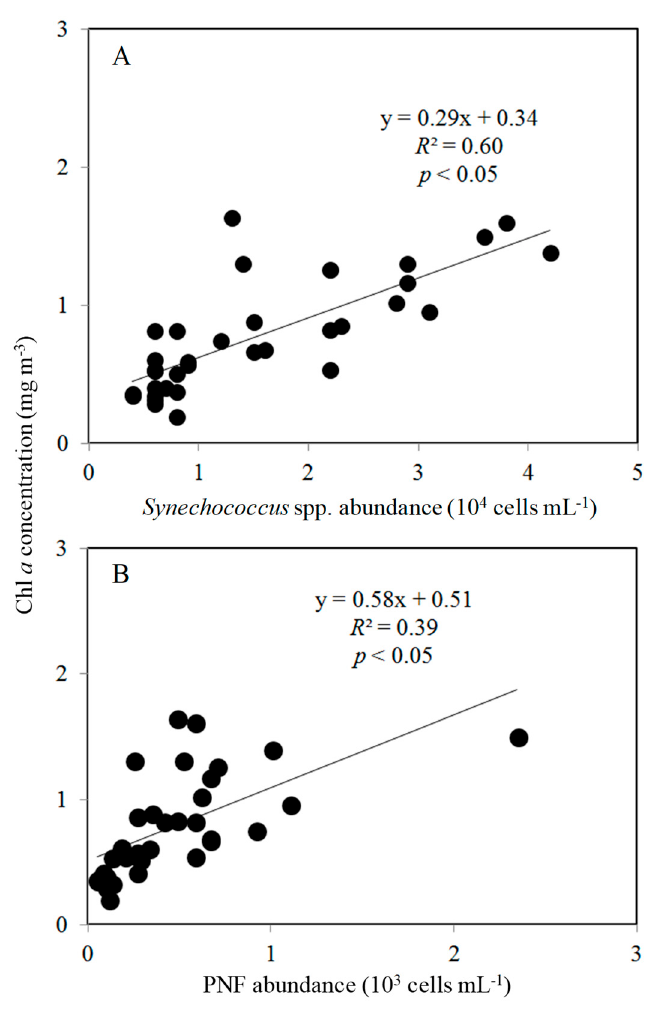
Figure 6. Relationship between Synechococcus spp. ( A ), PNF abundance ( B ), and Chl a concentration during the study period. The solid line is the regression line for all data.